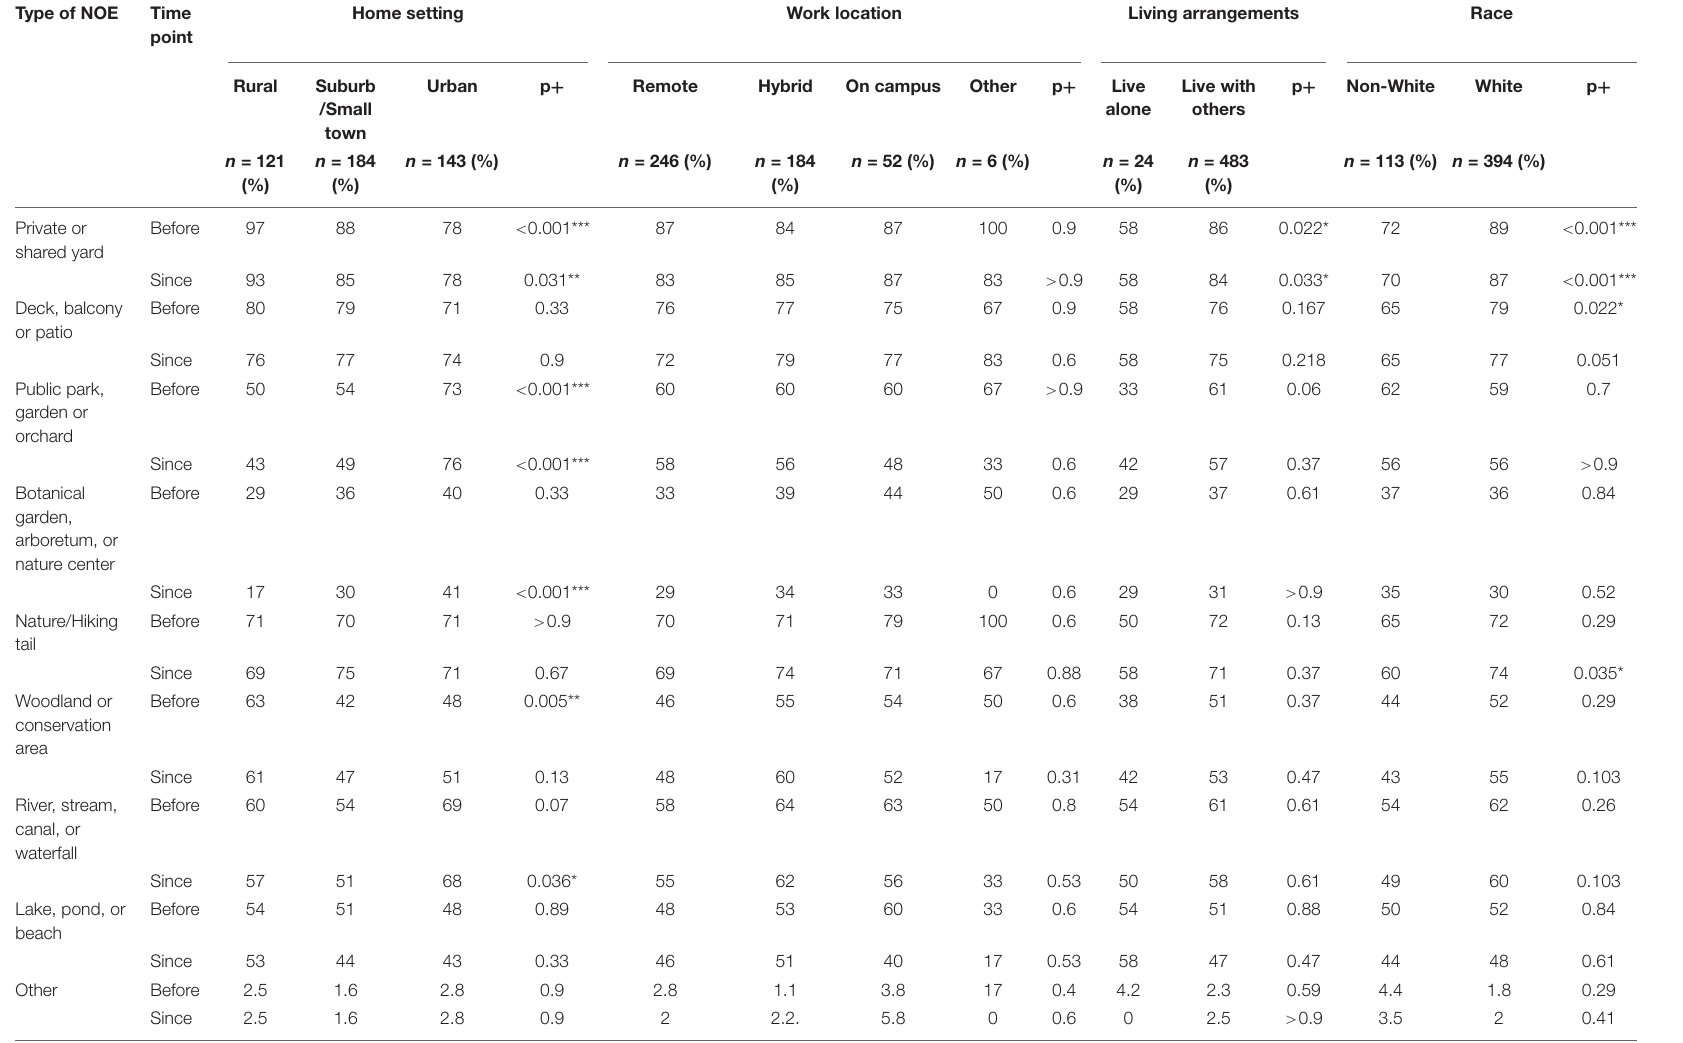
TABLE 5 | Differences in natural outdoor environment (NOE) use by